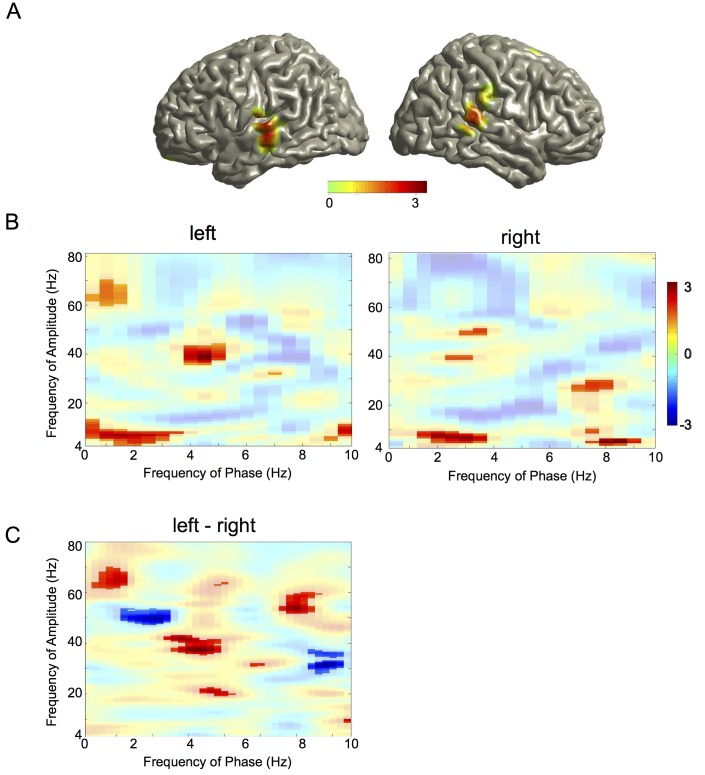
Cross-frequency phase-amplitude coupling.(A) Spatial distribution of theta phase to gamma amplitude coupling. Group statistical map of difference between story and back condition thresholded at p = 0.05 (FDR corrected). Colour code represents t-values. (B) Spectral distribution of phase-amplitude coupling in the auditory cortex. Cross-frequency phase-amplitude coupling quantified with MI is shown for the left and right auditory cortex. Pixels with significant difference between story and surrogate condition are displayed as opaque. (C) Lateralisation of cross-frequency phase-amplitude coupling. Pixels with significant lateralisation are displayed as opaque. Positive t-values indicate left-lateralized effects.